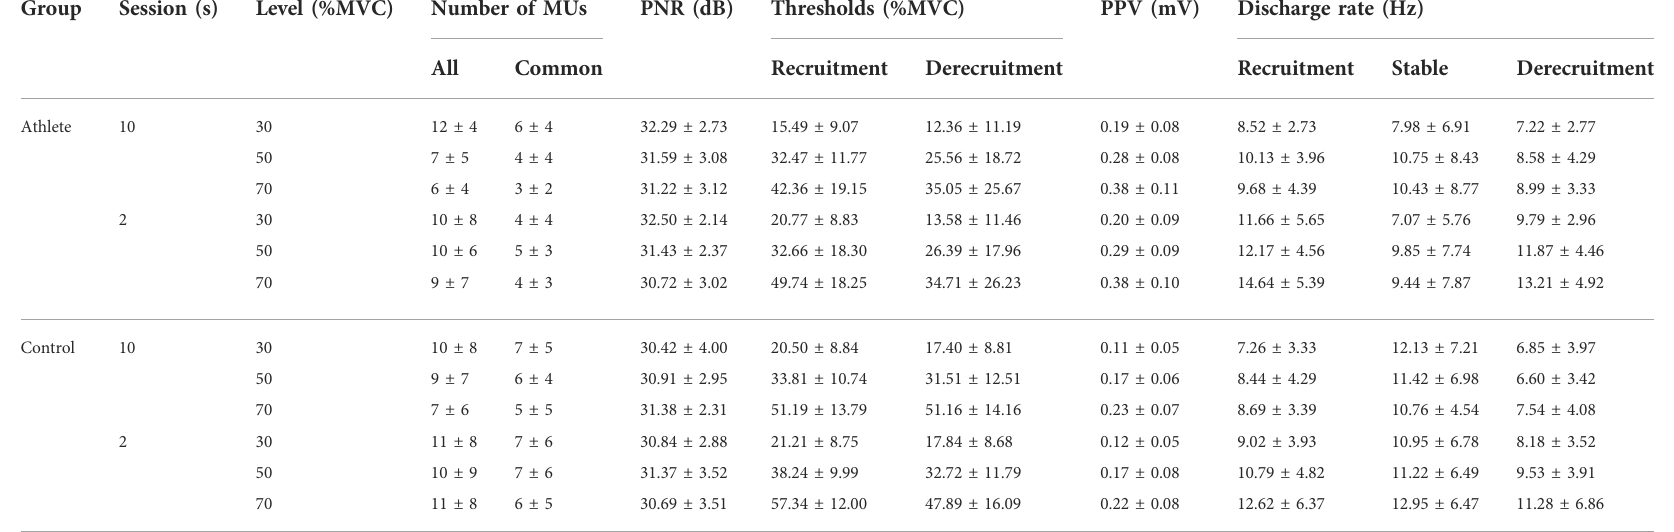
TABLE 2 Summary of decomposition